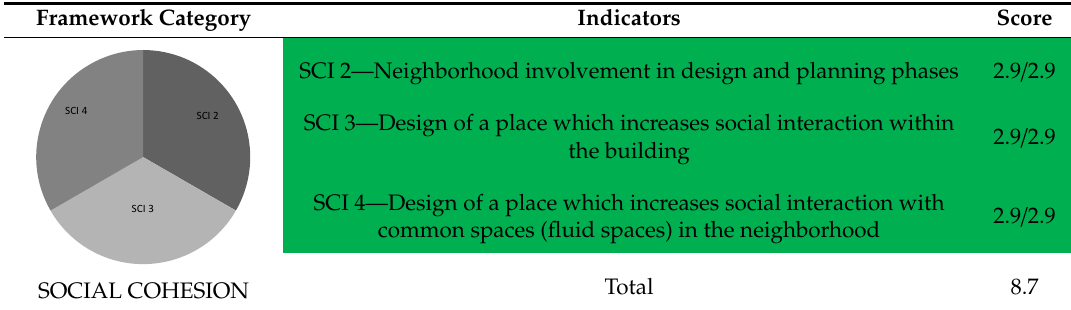
Table 11. RAG rating of Social Cohesion Indicator in Louroujina.